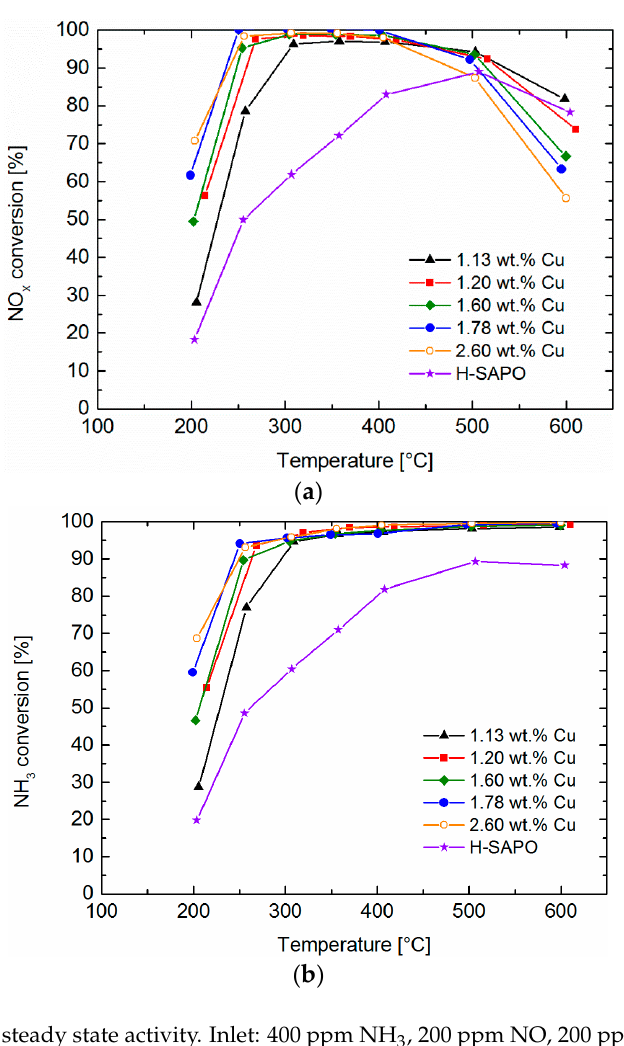
Figure 8. Fast SCR steady state activity. Inlet: 400 ppm NH 3 , 200 ppm NO, 200 ppm NO 2 , 8% O 2 , 5% H 2 O. ( a ) NO conversion; ( b ) NH 3 conversion.